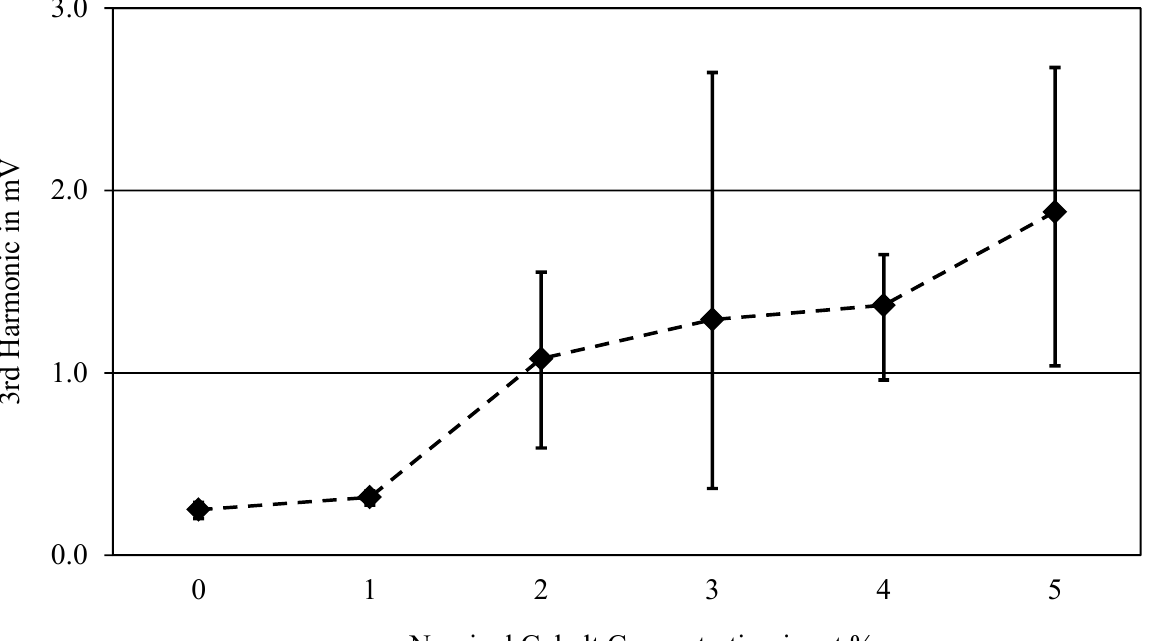
Figure 1. Amplitudes of the 3rd harmonic of the binary Mg-Co alloys’ cylinder specimens; eddy current ring sensor Ø 20 mm, test frequency 1.6